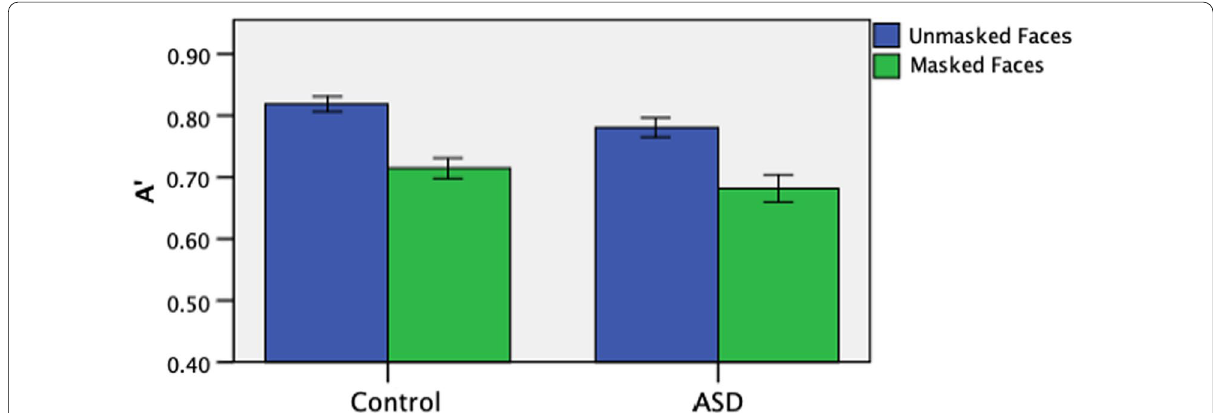
Fig. 2 A’ in the recognition of unmasked and masked faces in participants with and without ASD